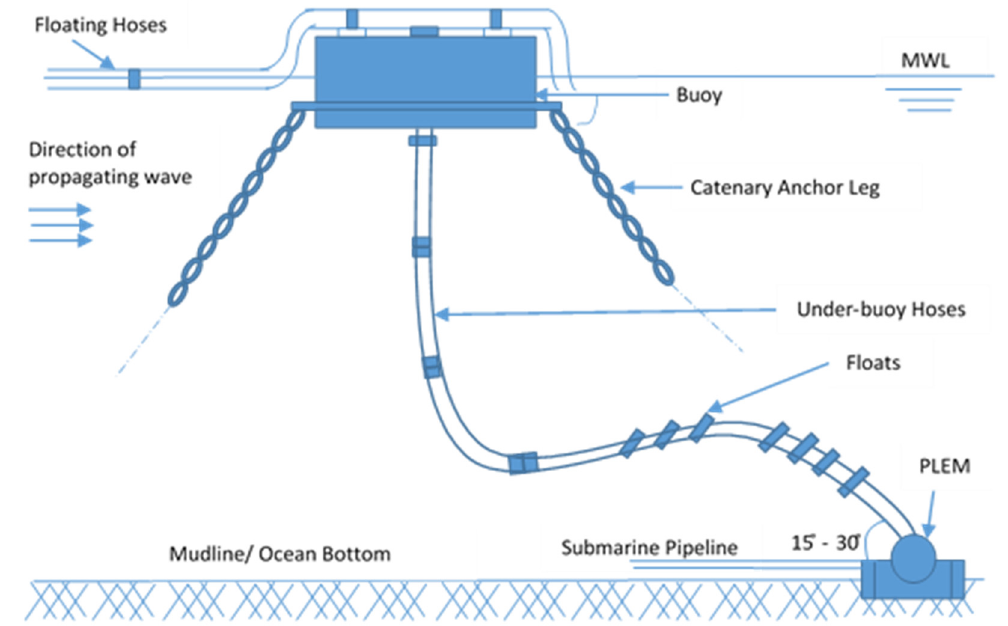
Figure 10. An illustration of Lazy-S Hose Configuration.